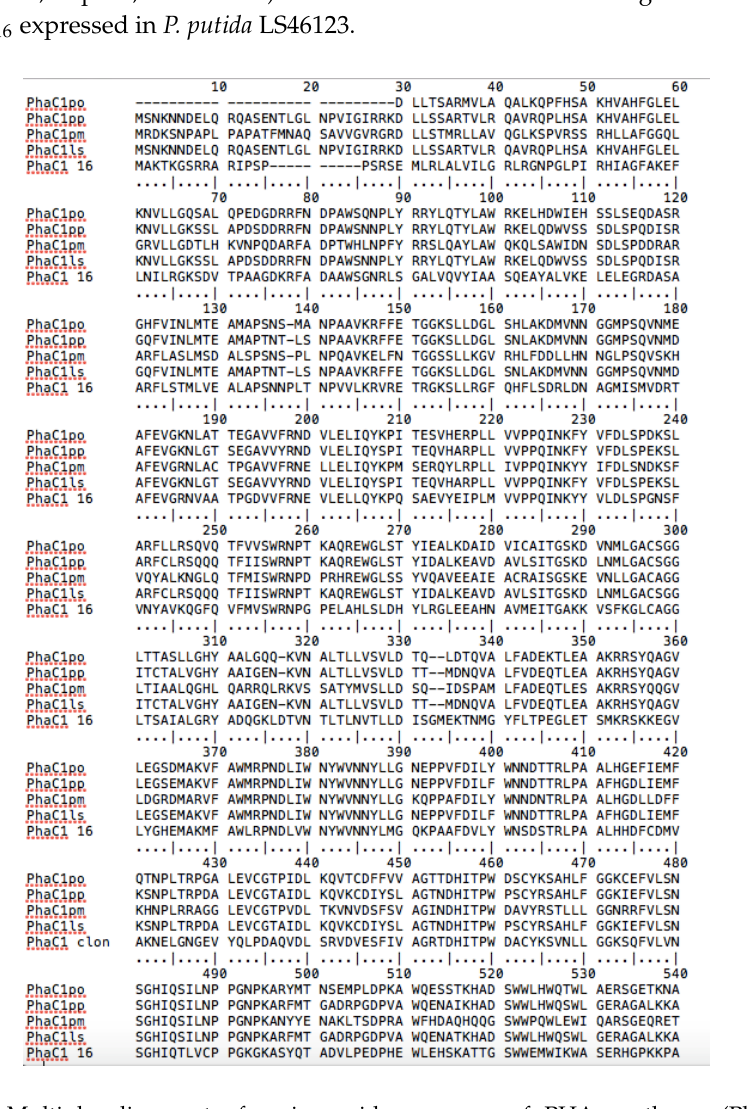
Figure 10. Multiple alignment of amino acid sequences of PHA synthases (PhaC1) from Pseudomonas oleovorans Gpo1 (PhaC1po), Pseudomonas putida KT2440 (PhaC1pp), Pseudomonas putida LS46 (PhaC1ls), and PhaC1 16 using Clustal Omega.